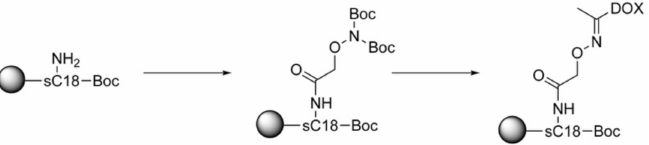
Scheme 9. Simplified introduction of the oxime ligation, according to reference